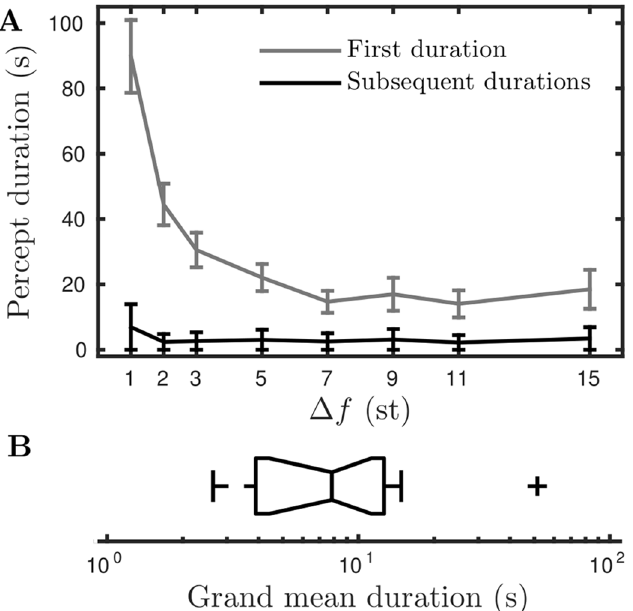
Fig 11. First and subsequent durations, summary statistics of the subject ’ s grand mean durations. A : Mean first percept duration and mean subsequent percept duration for all durations combined across both percept types, N = 16 subjects and R = 3 repetitions. Error bars show standard error of the mean. B : Standard Tukey box plot of T glob for N = 16 subjects (box shows quartiles, whiskers are most extreme data points within 1.5 × iqr of the upper and lower quartiles, “ + ” are individual outliers).